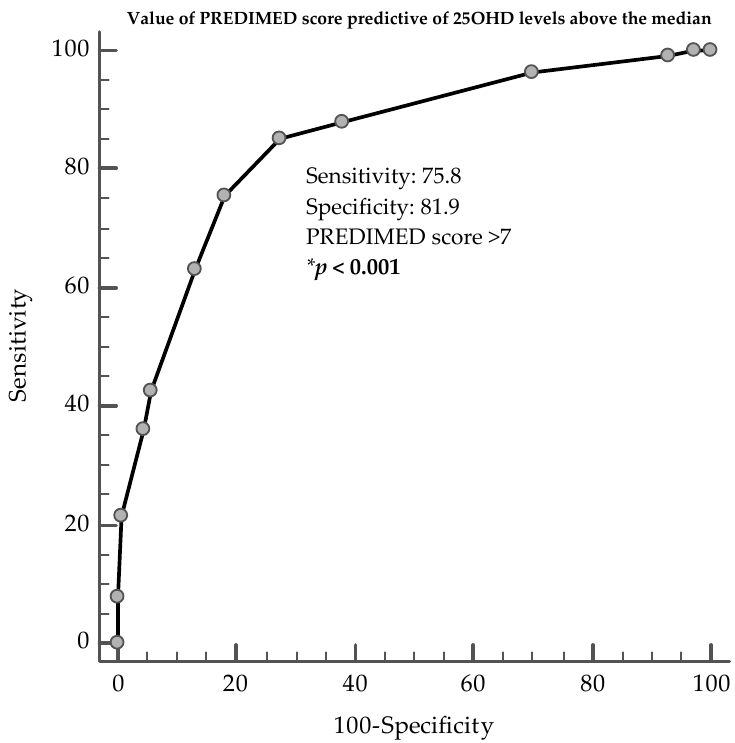
Figure 3. ROC for value of PREDIMED score predictive of 25OHD levels above the median, in males. * A p -value in bold type denotes a significant difference ( p < 0.05).